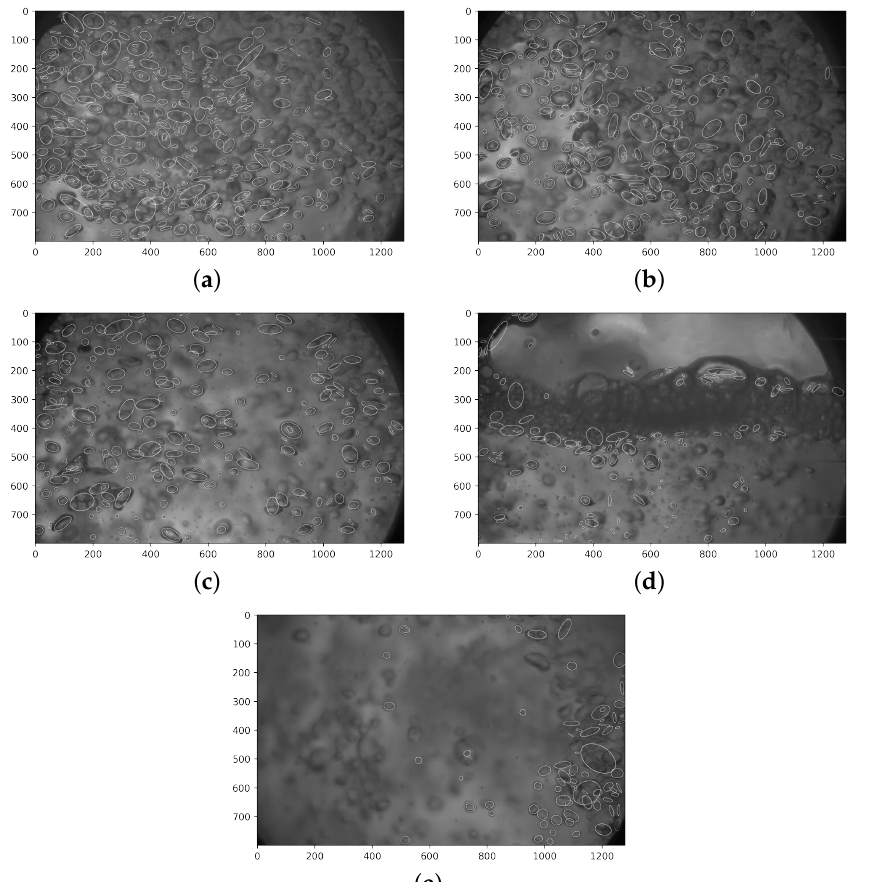
Figure 10. Sample images of fitted ellipses on frames from ( a ) F1, ( b ) F2, ( c ) F3, ( d ) F4 and ( e ) F5 videos according to Table 1. Although there are just sample frames, one can still see some